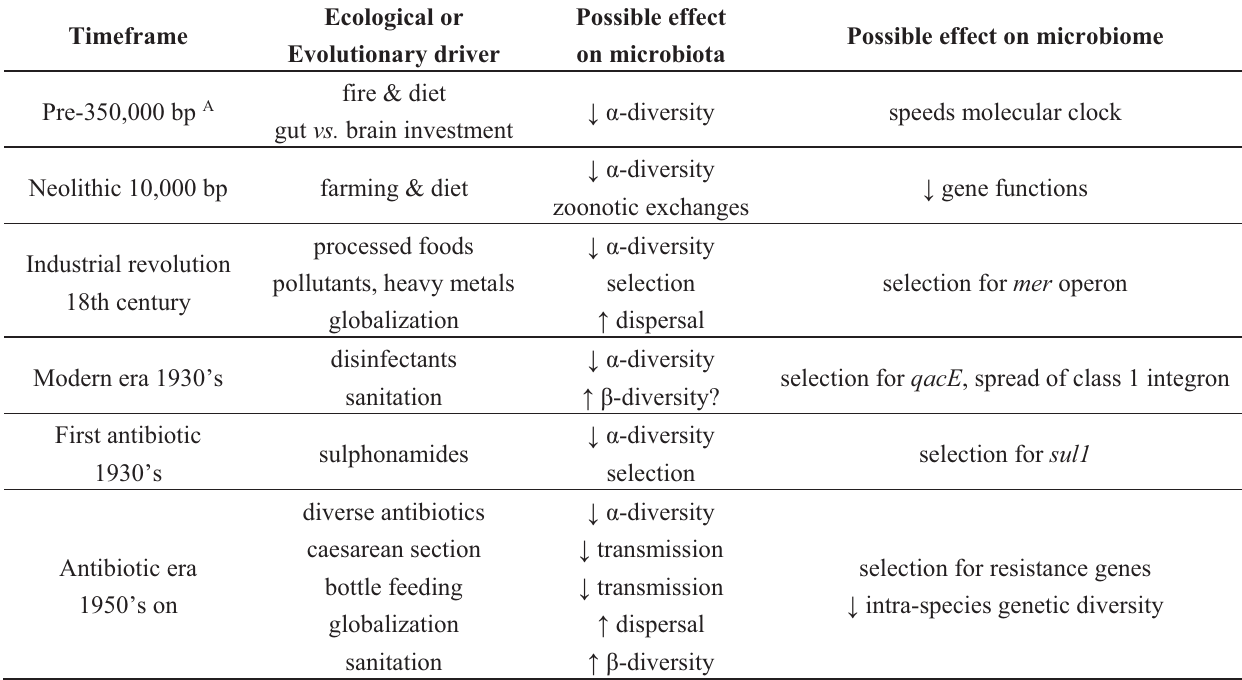
Table 1. A proposed history of ecological and evolutionary effects on the human